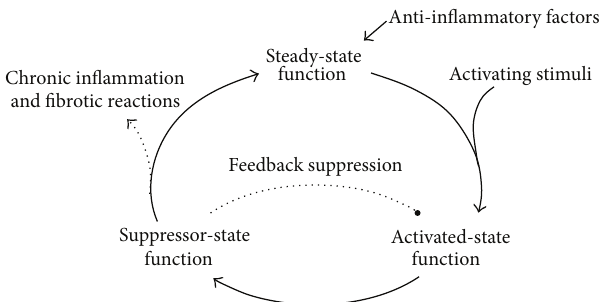
Figure 2: Mononuclear phagocytes are vital for control of inflam- matory responses. Mononuclear phagocytes are highly adaptable effector cells that engage in diverse, often antagonistic processes: DC and macrophages are capable of both stimulating or suppressing T cell-mediated responses depending upon their state of activation. Under normal physiological, noninflammatory conditions, imma- ture DC and macrophages present self and innocuous antigens to T cells in a subimmunogenic context. Recognition of cognate antigen in the absence of costimulation causes effector T cells to die, become anergic, or convert into regulatory T cells. Thereby, antigen presentation by nonactivated mononuclear phagocytes contributes to the steady-state maintenance of self-tolerance. A second “class” of myeloid regulatory cell arises as a consequence of persistent stim- ulation with proinflammatory mediators. Such activation-induced myeloid suppressor cells presumably serve as counterregulators that limit self-injurious inflammatory responses. Activation-induced myeloid regulatory cells are phenotypically diverse and operate through a variety of mechanisms, including production of T cell- suppressive soluble factors, receptor-mediated killing of effector T cells, and the activation-dependent induction of